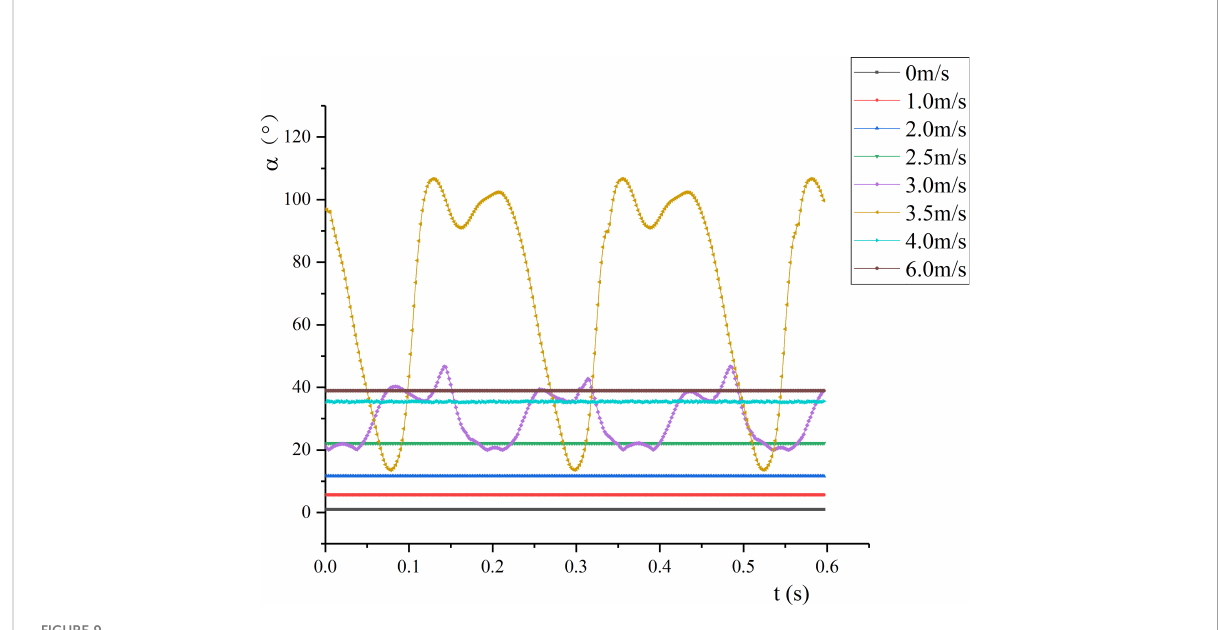
FIGURE 9 Petiole bending